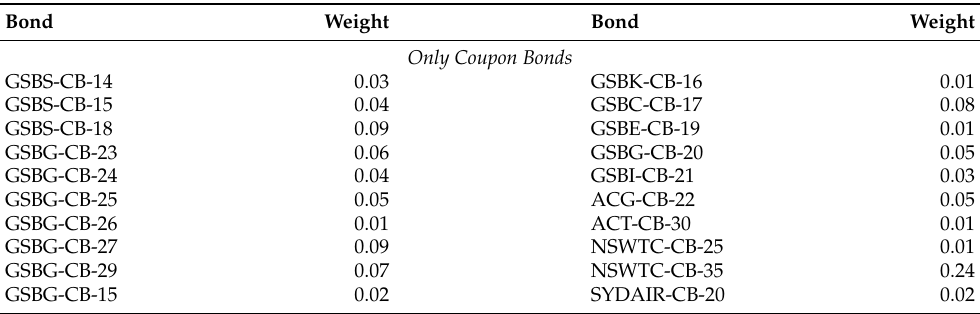
Table 12. Bond Portfolios to Immunize a Life Annuity Issued to 65 year